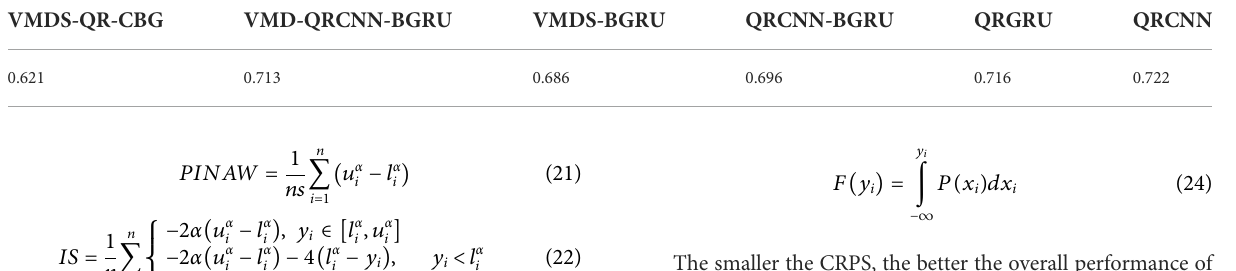
TABLE 3 The values of the CRPS of different